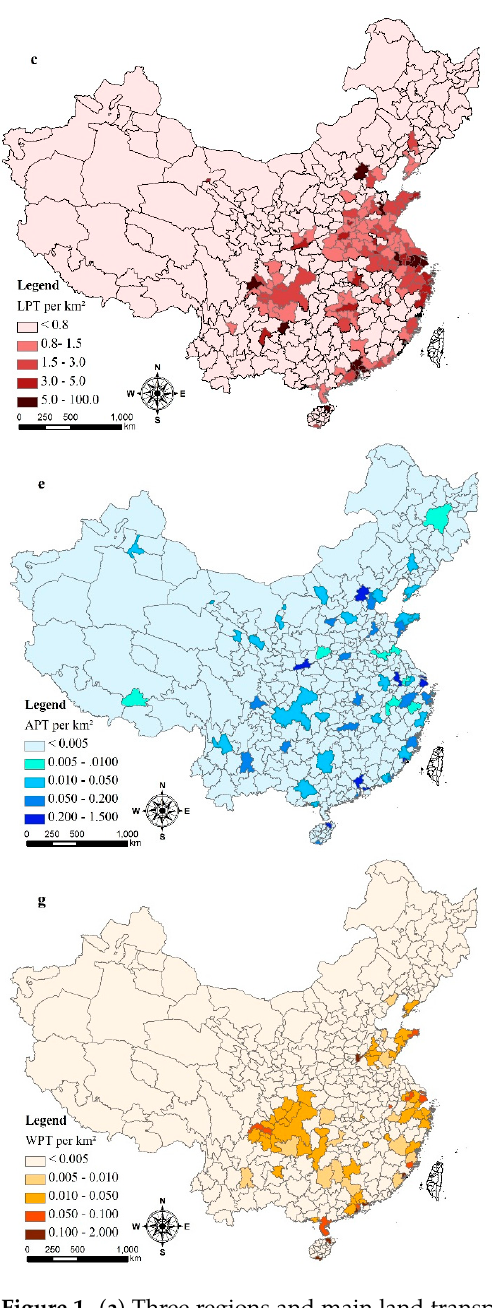
Figure 1. ( a ) Three regions and main land transport network in China; density of ( b ) GDP; ( c ) land passenger traffic; ( d ) land freight volume; ( e ) air passenger traffic; ( f ) air freight volume; ( g ) water passenger traffic and ( h ) water freight volumes.